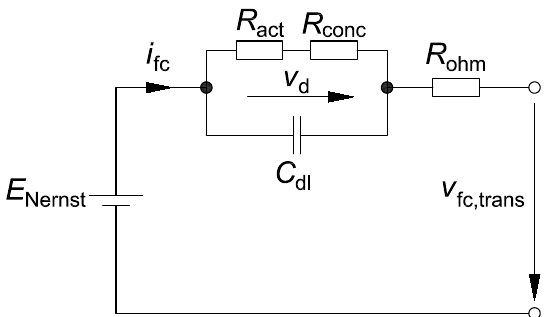
Figure 3. Electrical equivalent circuit for the description of the effect of the electrochemical double layer on transient cell voltage and